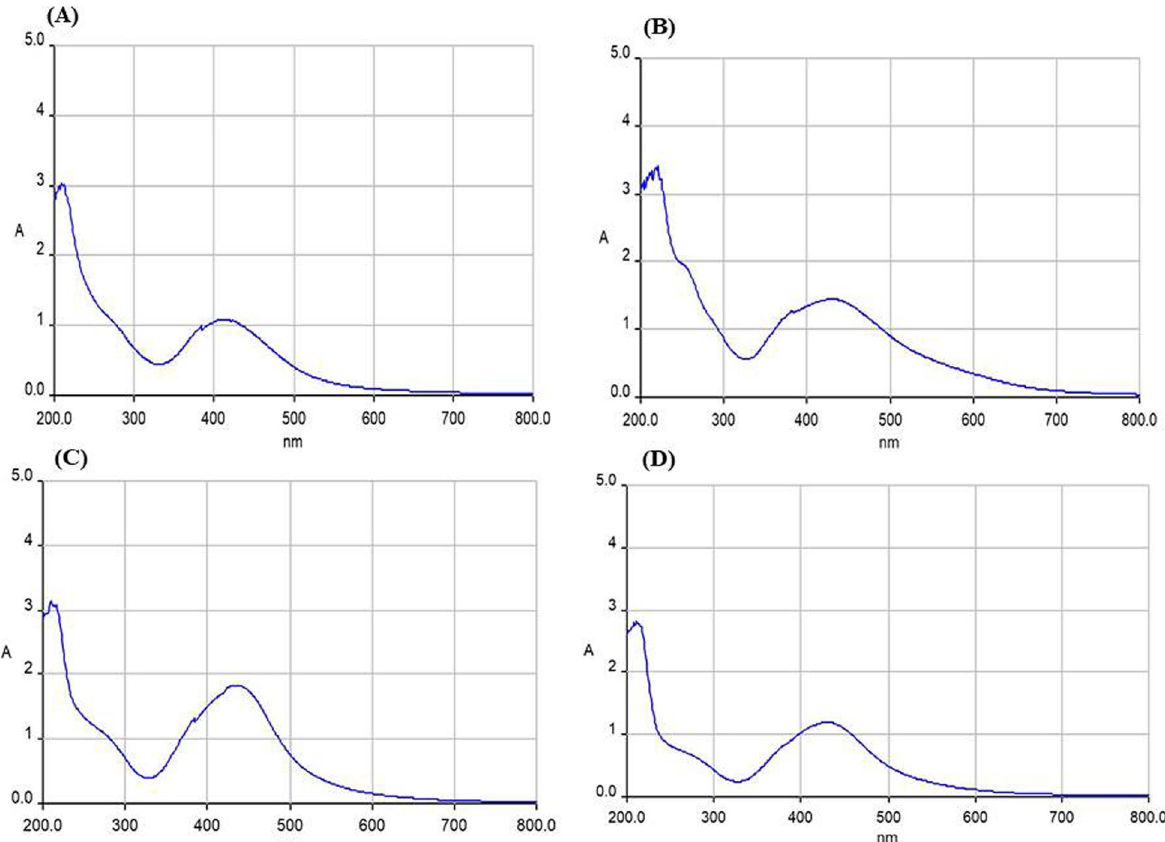
Fig. 2 The graph obtained from the UV–Vis spectra of greener AgNPs formed from aqueous solution of AgNO3 with Litsea glutinosa leaf extract in different ratios- A ) Glu 1:1, B ) Glu 1:2, C ) Glu 1:4 & D ) Glu 1:8